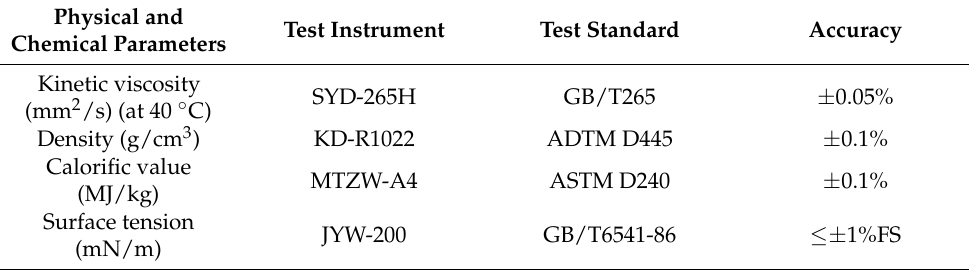
Table 1. Main instruments and test standards.